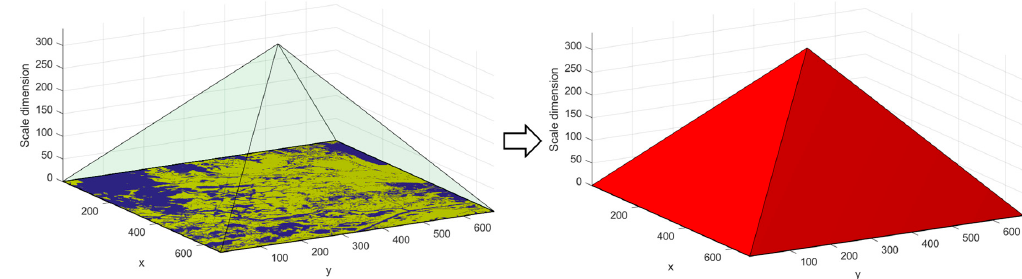
Figure 17. Constructing a pyramid model (PM) from the land cover data at the base layer.